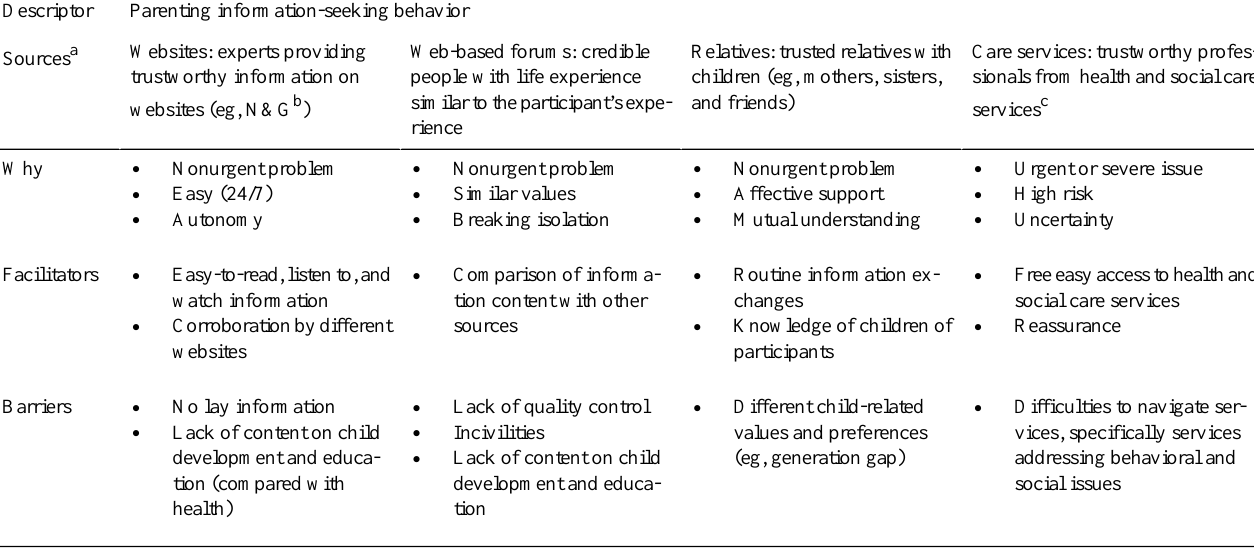
Table 5. Qualitative component: participants’information-seeking behavior. Parenting information-seeking